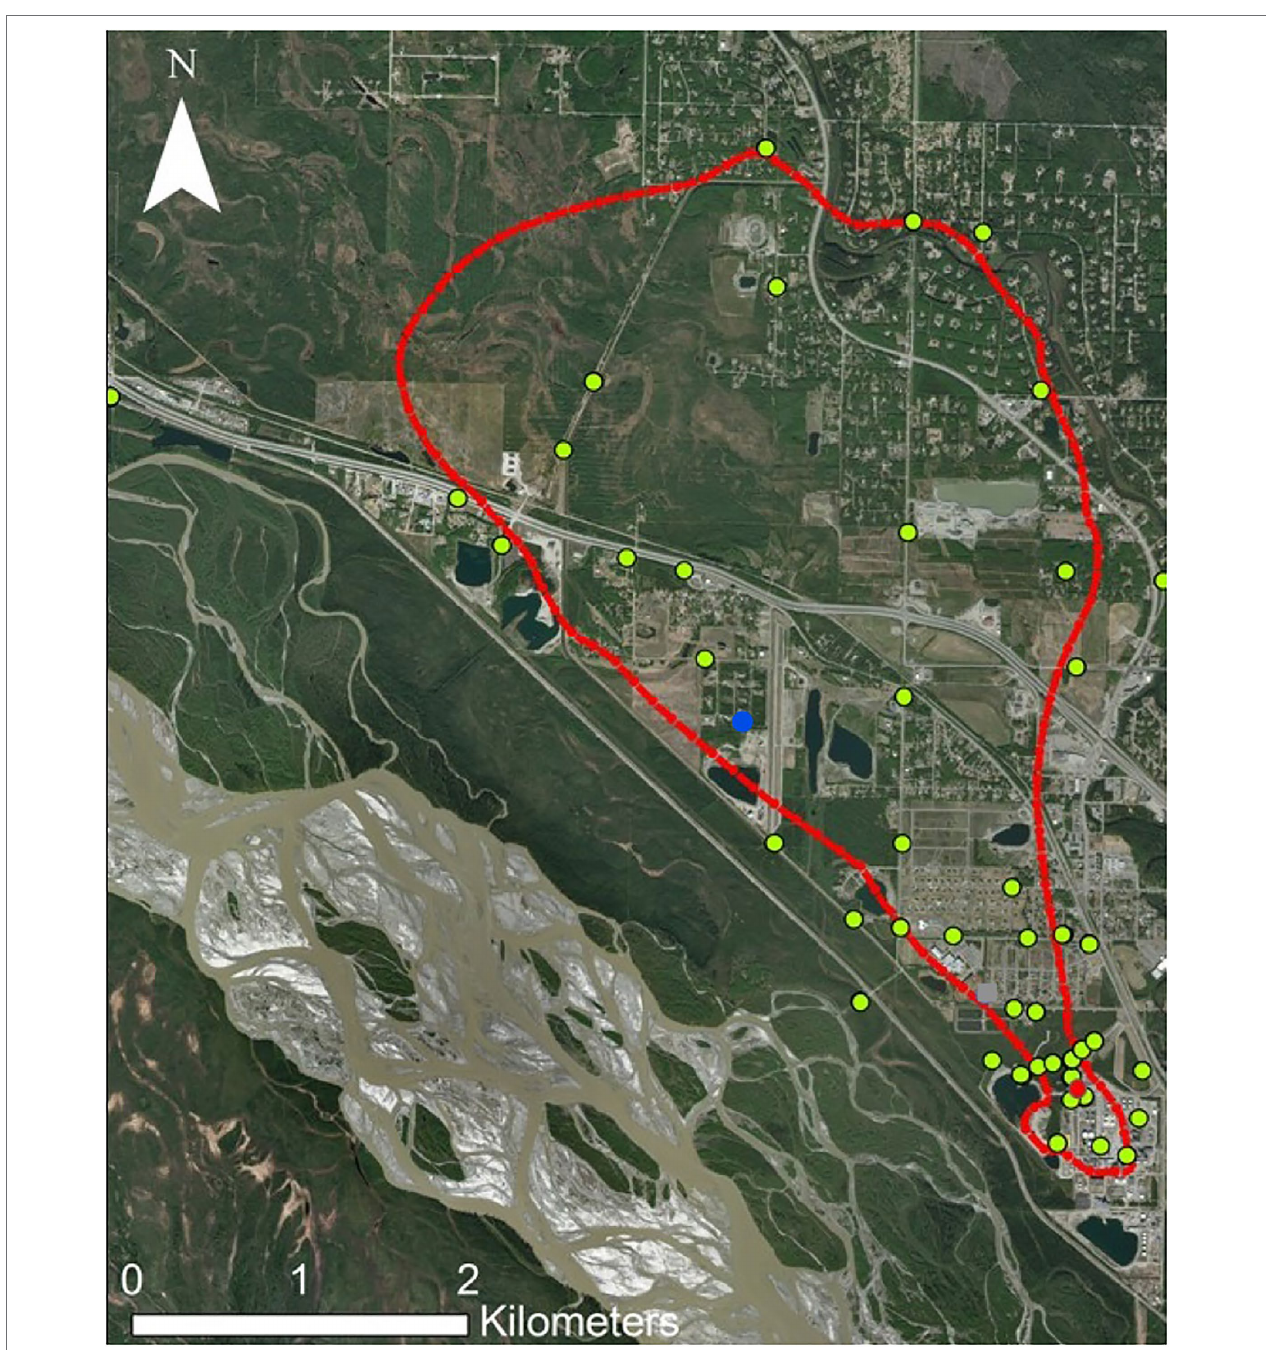
FIGURE 1 | Map of the sulfolane plume in North Pole, Alaska. The red outline represents the extent of detectable sulfolane in the groundwater. The yellow dots represent monitoring wells sampled. The red dot represents the location of the experimental air-sparging system. The blue dot is the location of the granular activated carbon (GAC)